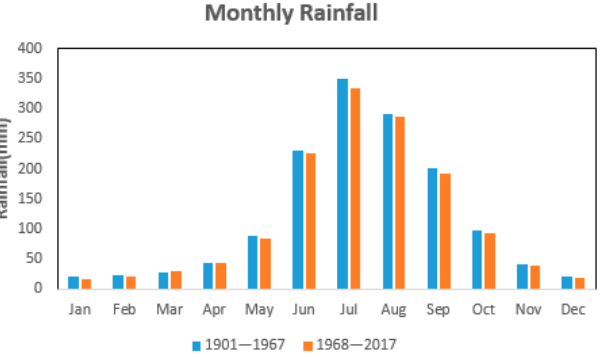
Figure 5. Monthly average rainfall comparison between first 67 years and recent 50